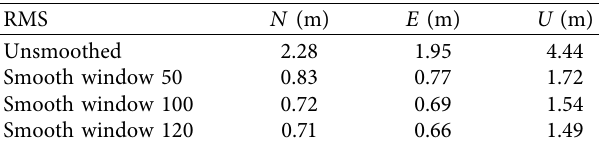
Table 3: 5G smart communication base station smoothing pseu- dorange positioning outside conformal accuracy (RMS) statistics. RMS